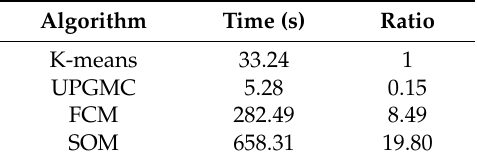
Table 1. Required execution time for 2 to 30